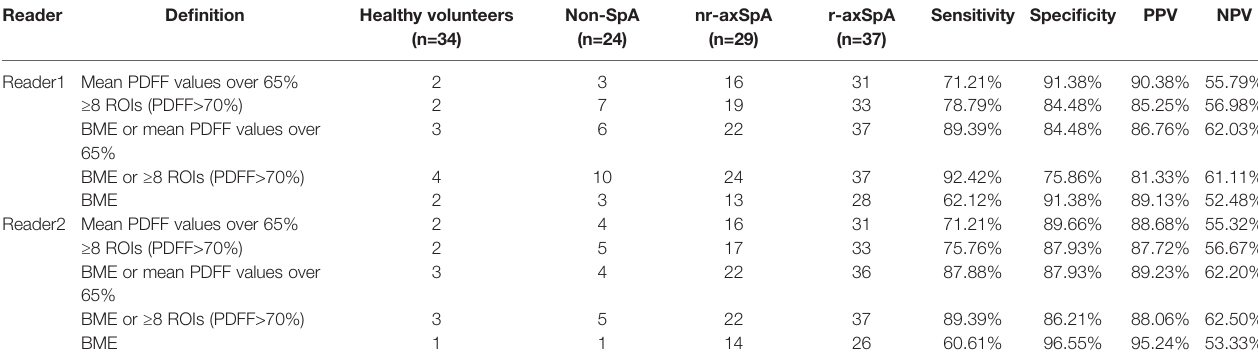
TABLE 6 | Sensitivities and speci fi cities of the 5 candidate de fi nitions of a positive SIJ MRI in study subjects excluding patients with bDMARDs medication. Reader